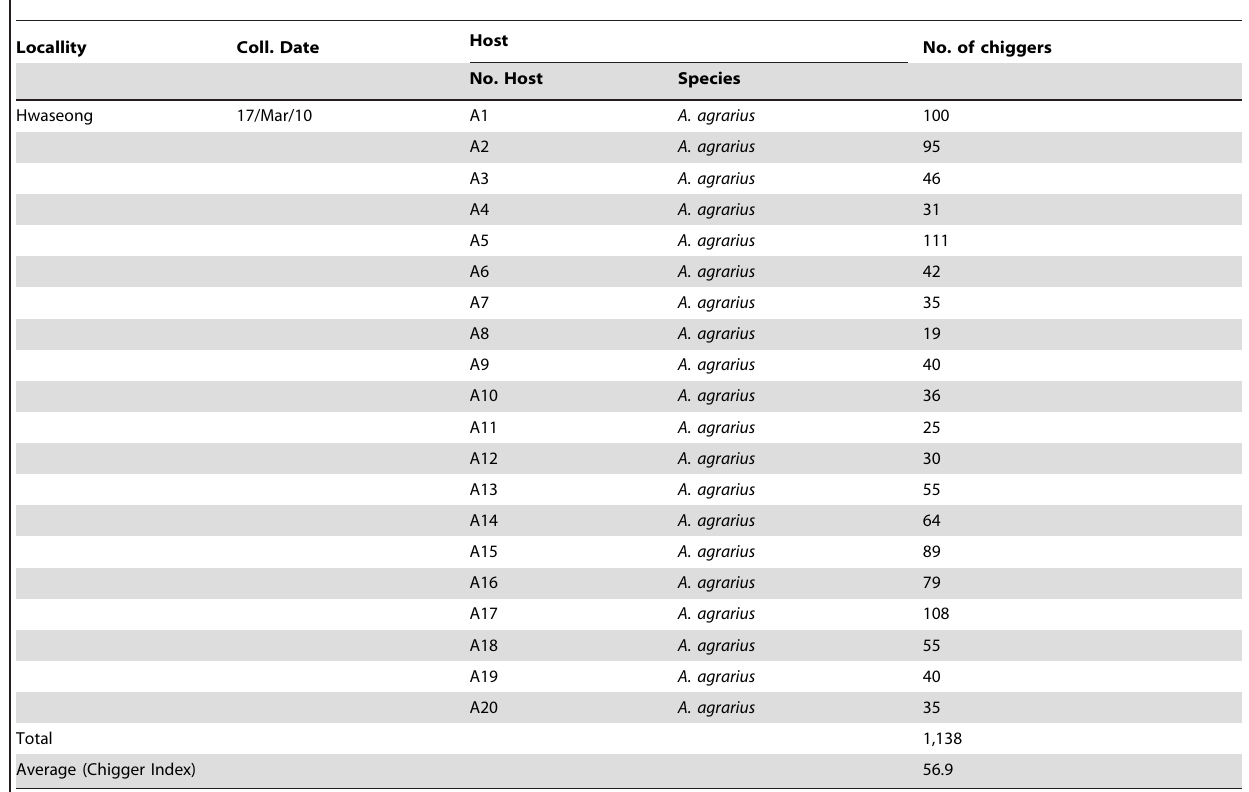
Table 1. The chigger mite collected from the captured wild rodents in Hwaseong.